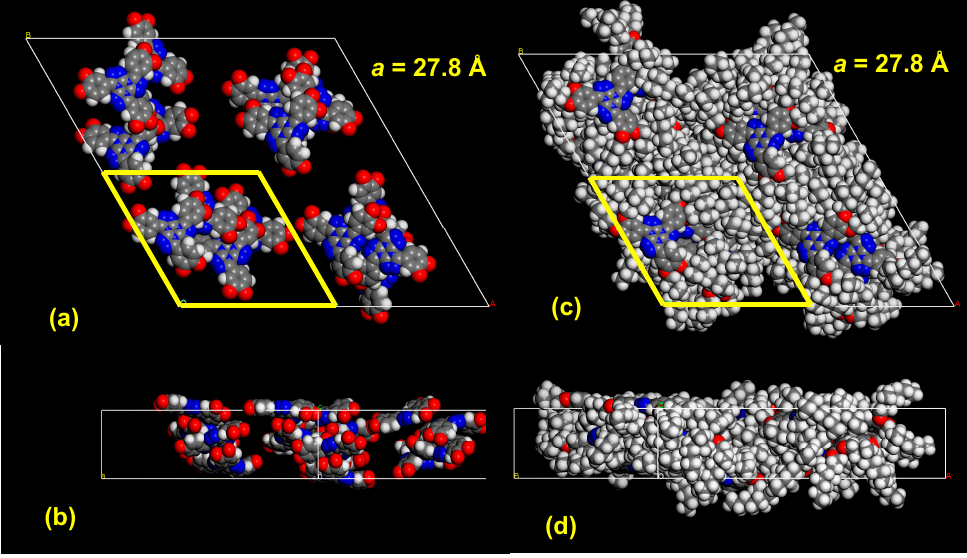
Figure 5. Modeled liquid crystal (LC) phase of t-60 : ( a , b ): top and side view on columns in the c-direction, where alkyl chains are omitted; ( c , d ) top and side view.